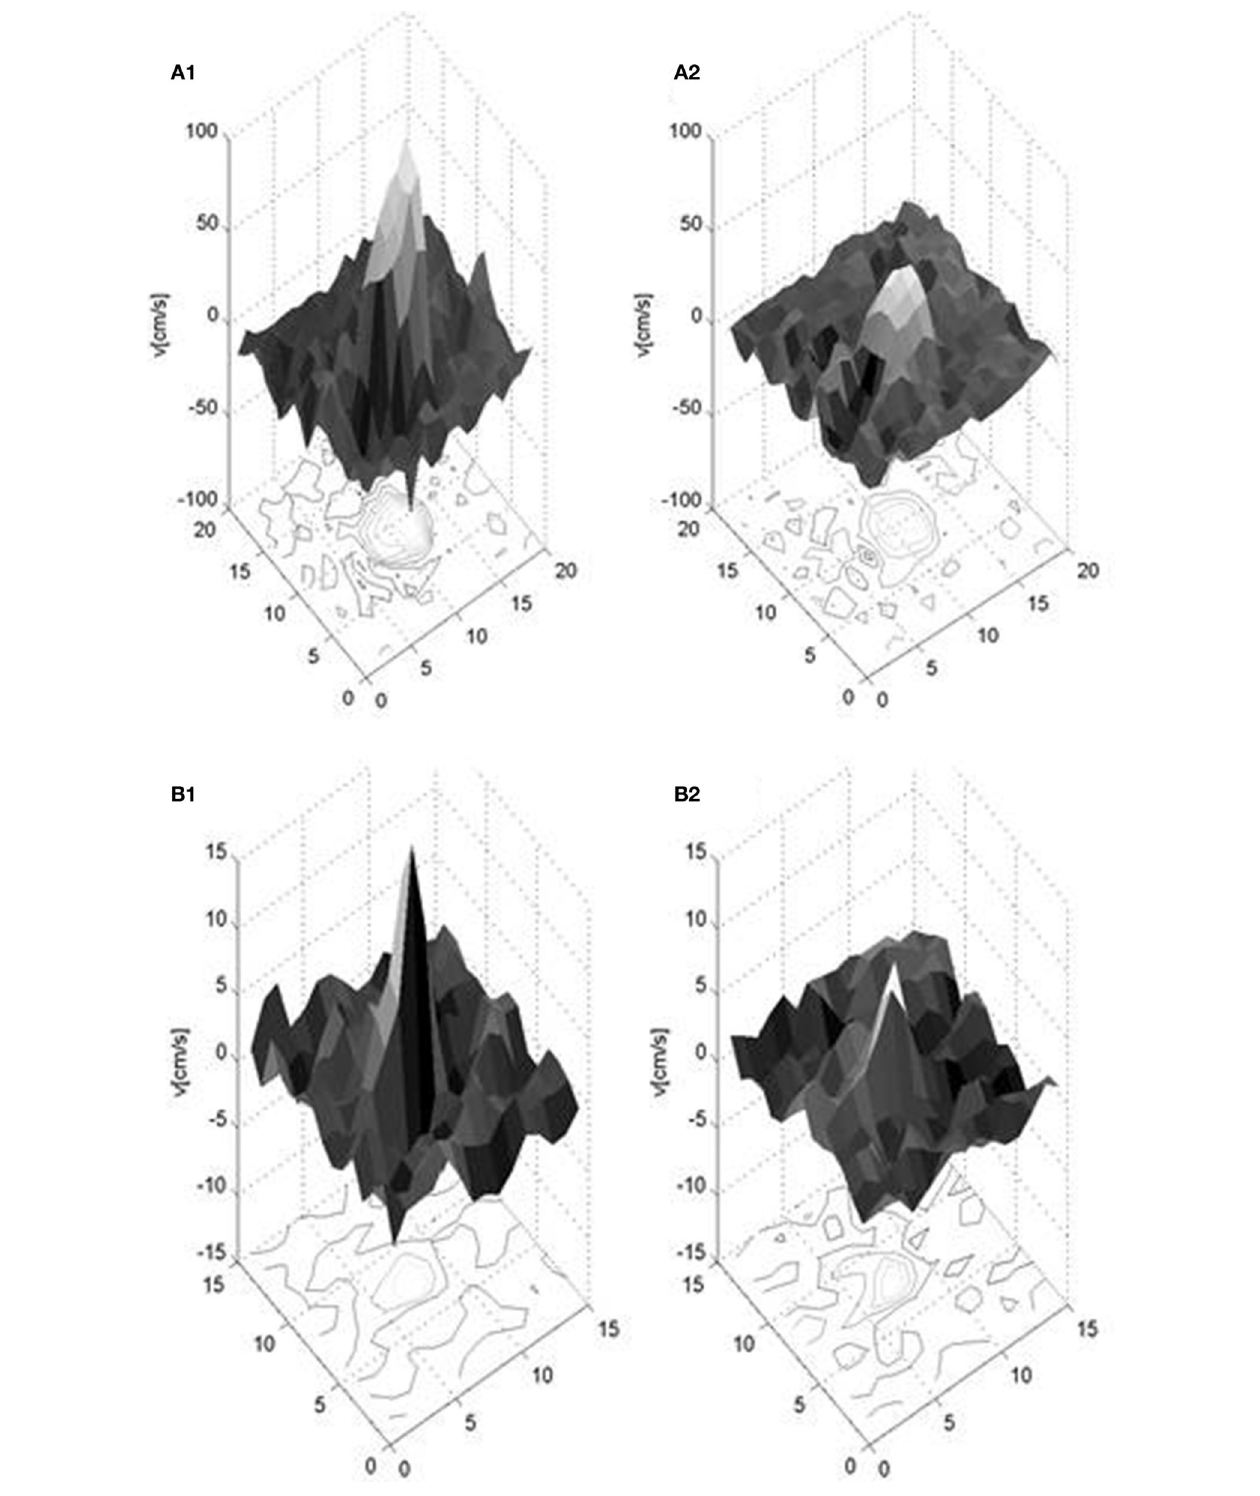
FIGURE 3 | Exemplary spatial velocity profiles in a young healthy subject for the MCA (upper: A1,A2 ) and LSA (lower: B1,B2 ) for two cardiac phases, when the velocity has its maximum (left: A1, B1 ) and minimum (right: A2,B2 ) value. Note the different velocity scales along the vertical axes. The units of the two horizontal axes are in pixels and the depicted surface mesh shows the pixel size of the measurement.